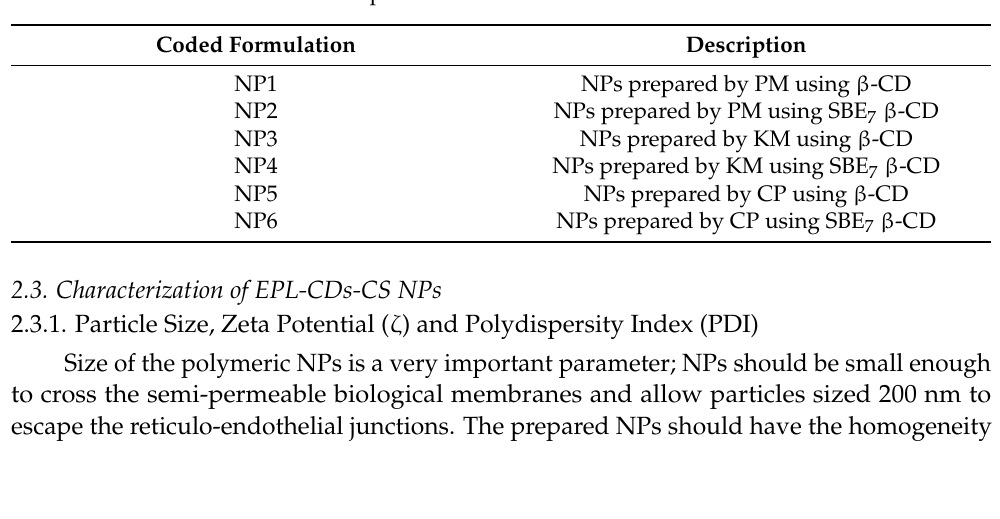
Table 2. Coded NPs and their